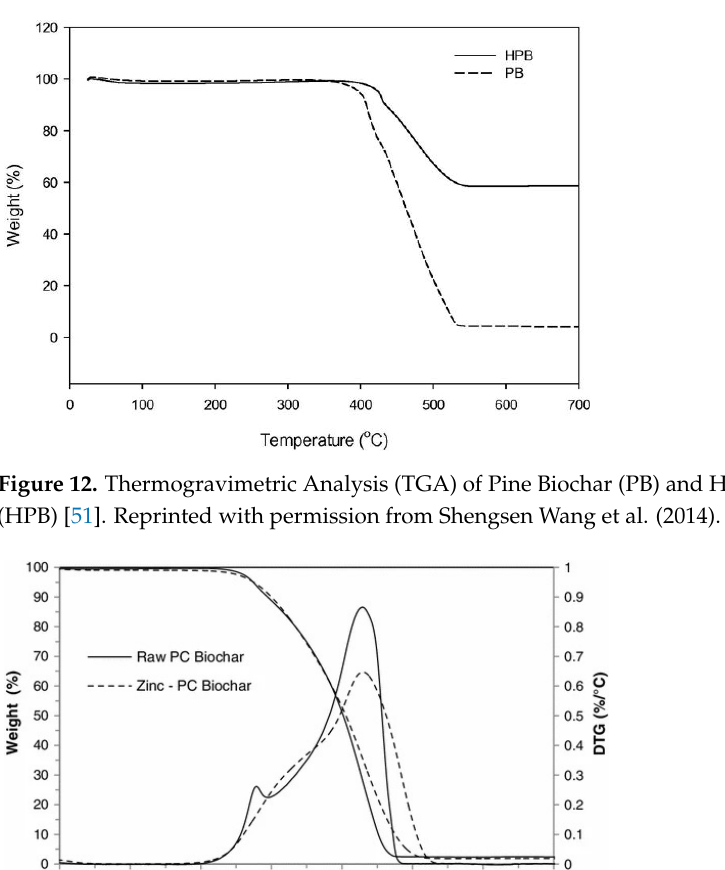
Figure 11. TG images of biogas residues, virgin biochar, and ZnCl 2 -impregnated biochar [108]. Re- printed with permission from DongXia et al. (2016). Copyright 2016, Elsevier.